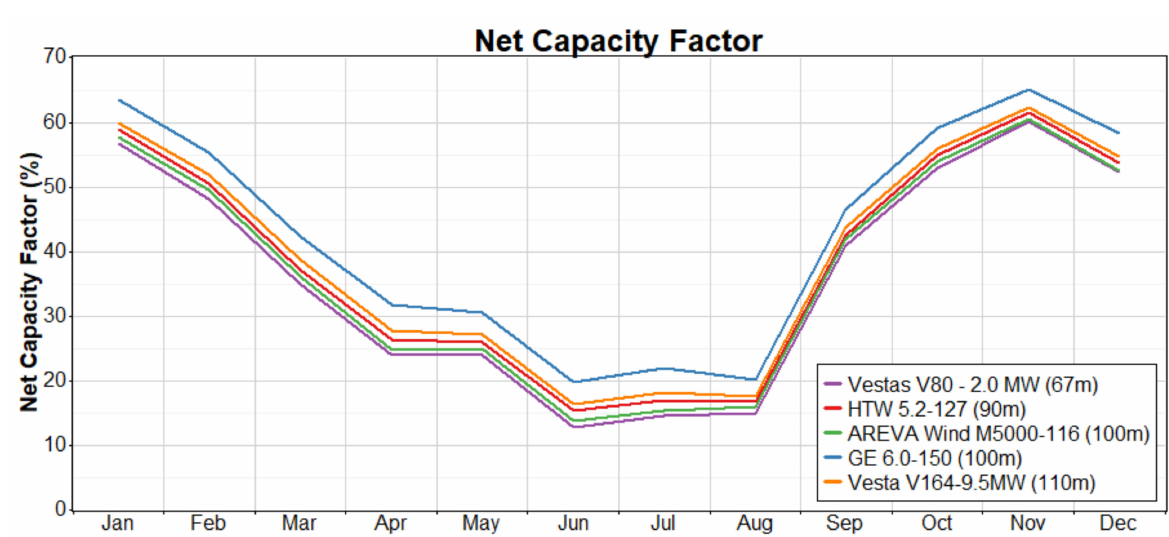
Figure 16. Summarized monthly net capacity-factor profile